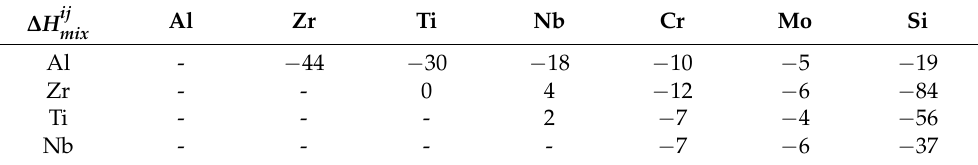
Table 2. The binary mixing enthalpy of the elements added in these HEAs [50].